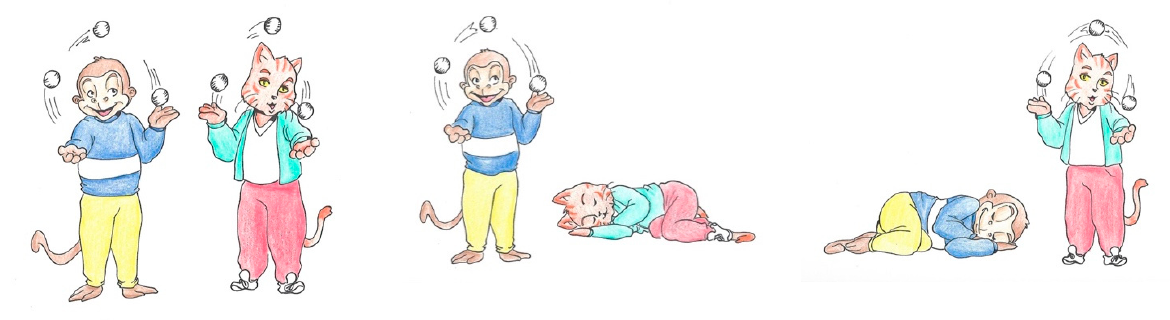
Figure A27. Filler stimulus 2.